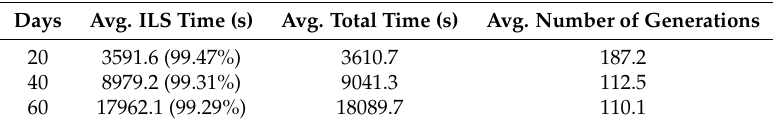
Table 5. Running time of